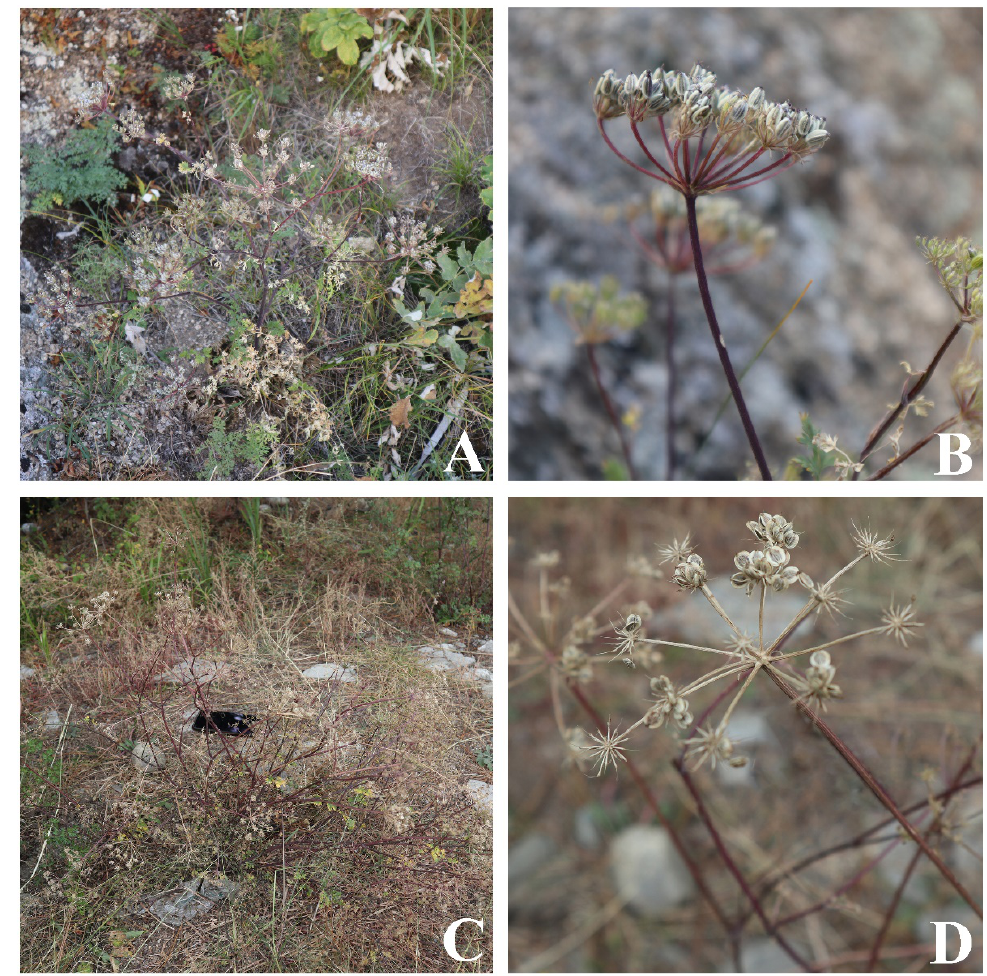
Figure 1. Morphology of P. nanum ( A , B ) and P. violaceum ( C , D ).